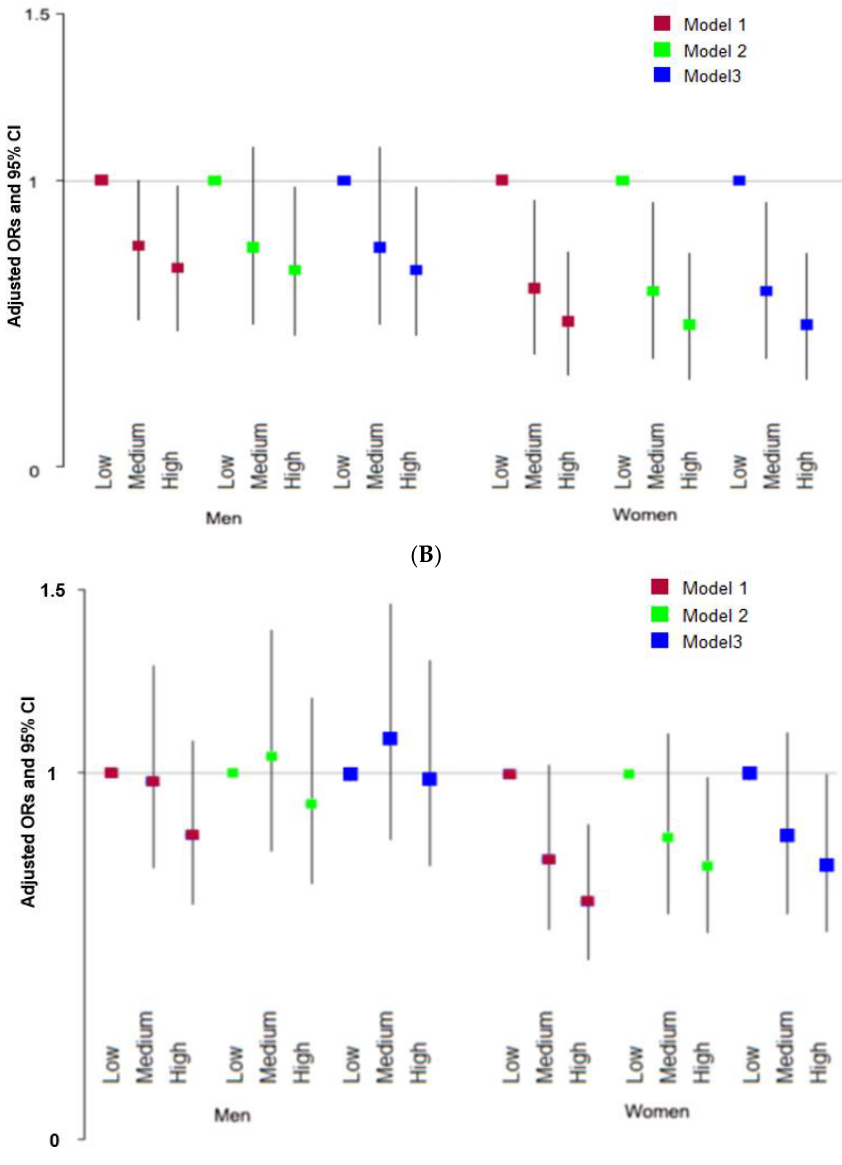
Figure 1. Association of the Korean healthy eating index (KHEI) scores with type 2 diabetes risk. ( A ) Adjusted odds ratio (ORs) of overall scores of KHEI and 95% confidence intervals (CI). ( B ) Adjusted ORs of adequacy scores of KHEI and 95% confidence intervals (CI). ( C ) Adjusted ORs of balance scores of KHEI and 95% confidence intervals (CI). ORs and 95% CI are represented with colored boxes and lines, respectively. Models were generated with different covariates, including age, gender, regions, and area of residence for model 1; covariates for model 1 plus education, income, marital status, and obesity for model 2; and covariates for model 2 plus energy intake, smoking, alcohol consumption, and regular exercise for model 3.